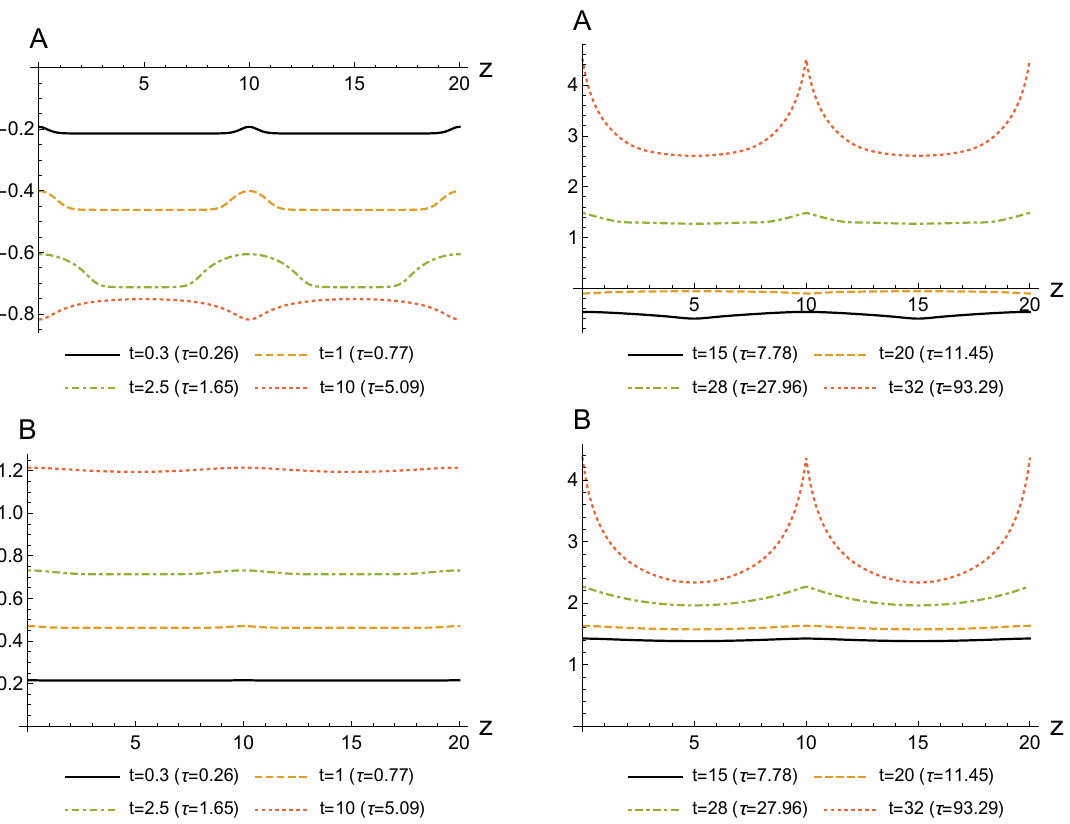
Figure 6 . The profiles of A and B at various times. The parameters are chosen as (4.6) and V min = 0